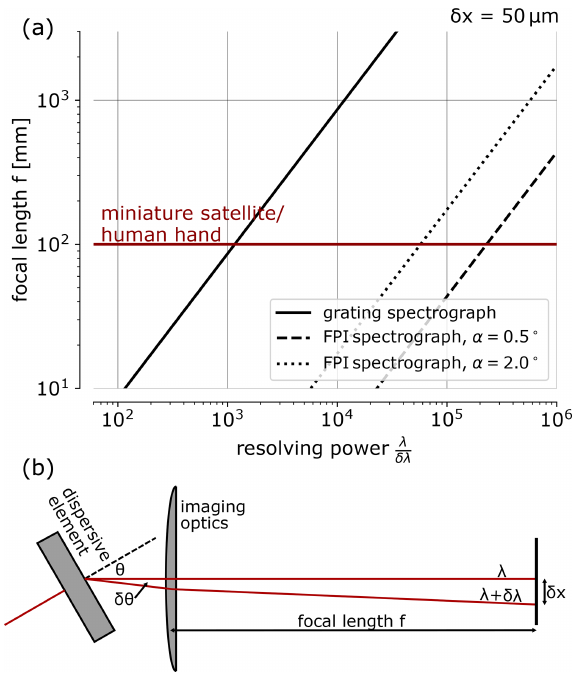
Figure 3. (a) Relationship between size (represented by the focal length) and resolving power of GS and FPI spectrographs for an ILF spatial dimension of δx = 50µm. The size of a human hand or a miniature satellite is about 10cm (red line); this size determines the favourable resolving power of the respective GS or FPI spec- trograph for many applications. (b) Schematic of a spectrograph illustrating the fundamental aspects that determine the values in panel (a) . The focal length f mainly determines the overall spec- trograph